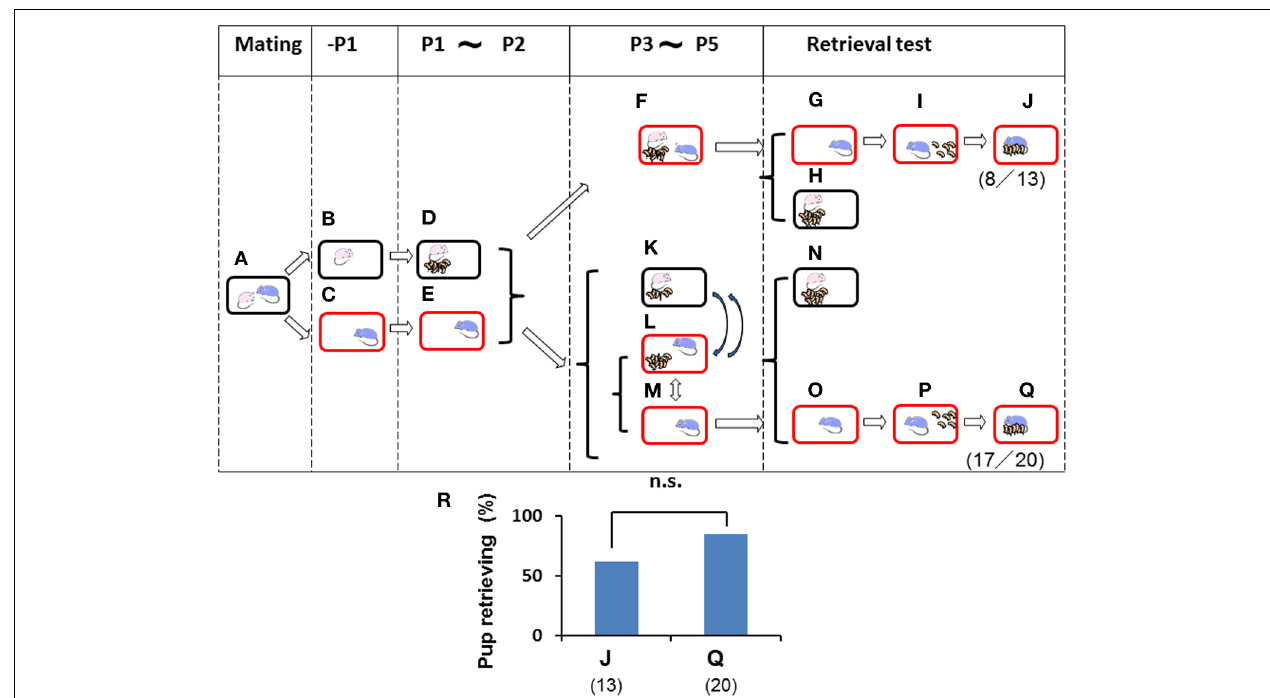
FIGURE 4 | Paternal retrieval test in mice isolated prior parturition from the mating pair and then united as a whole family or with pups only. A paired couple was kept in a rearing cage from mating (A) to 1 day before parturition. The female was kept in a home cage (B) and delivered her pups (D) and remained until postnatal day 2 (P2) (D) . The male was kept in a new cage before meeting the pups (C) and kept until P2 (E) . The dam and pups were introduced in the sire’s own (new) cage and stayed as a whole family until P5 (F) . Instead of the whole family, in another experiment, only pups in home cages with their dams (K) were transferred